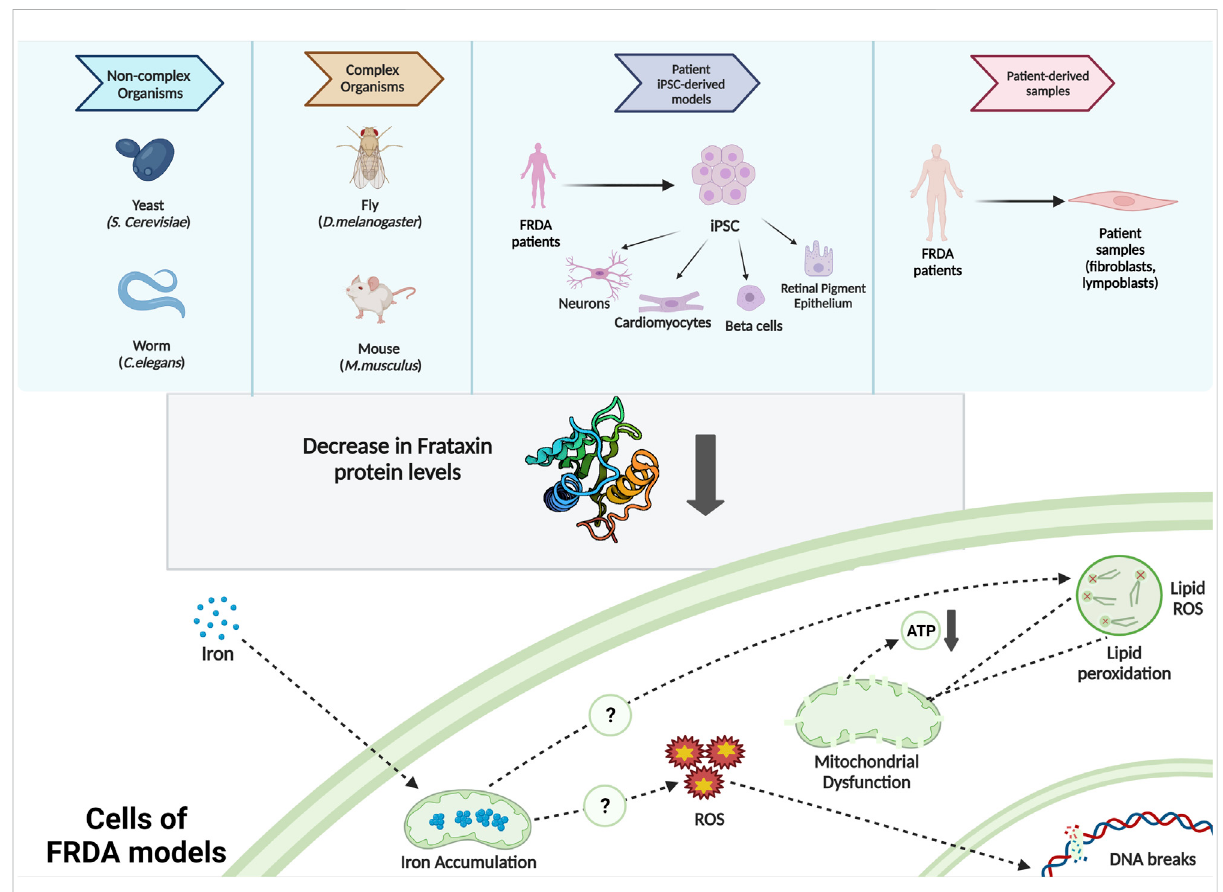
FIGURE 1 Commonly used FRDA models and the intracellular molecular phenotypes